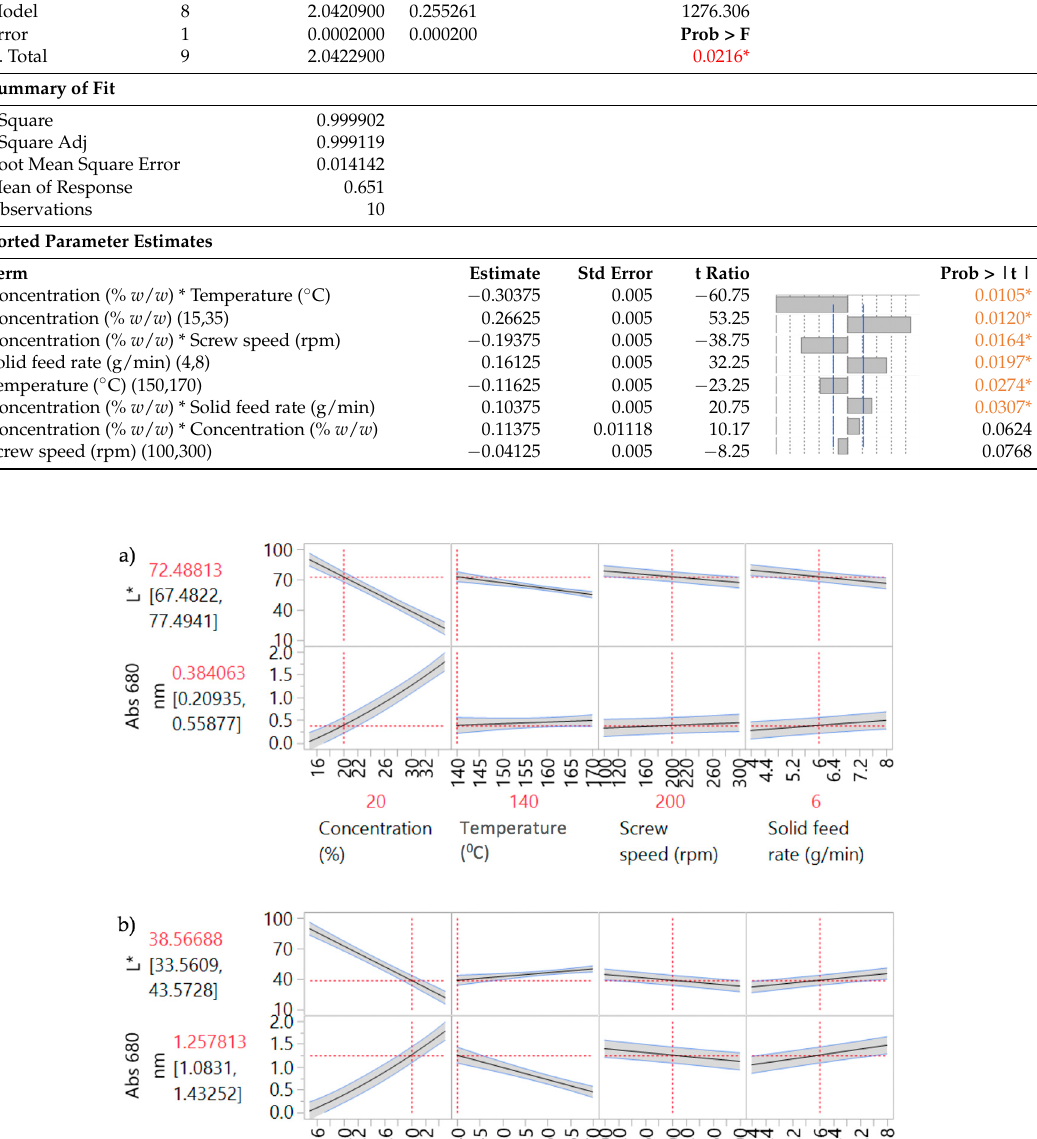
Figure 4. Prediction profilers for DoE1 for ( a ) 20% w / w and ( b ) 30% w / w PRX concentrations.